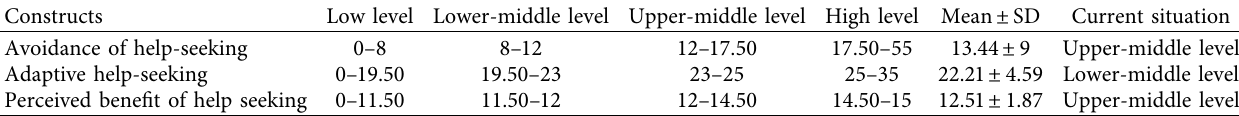
Table 2: The status of research help-seeking in residents of ophthalmology. Constructs